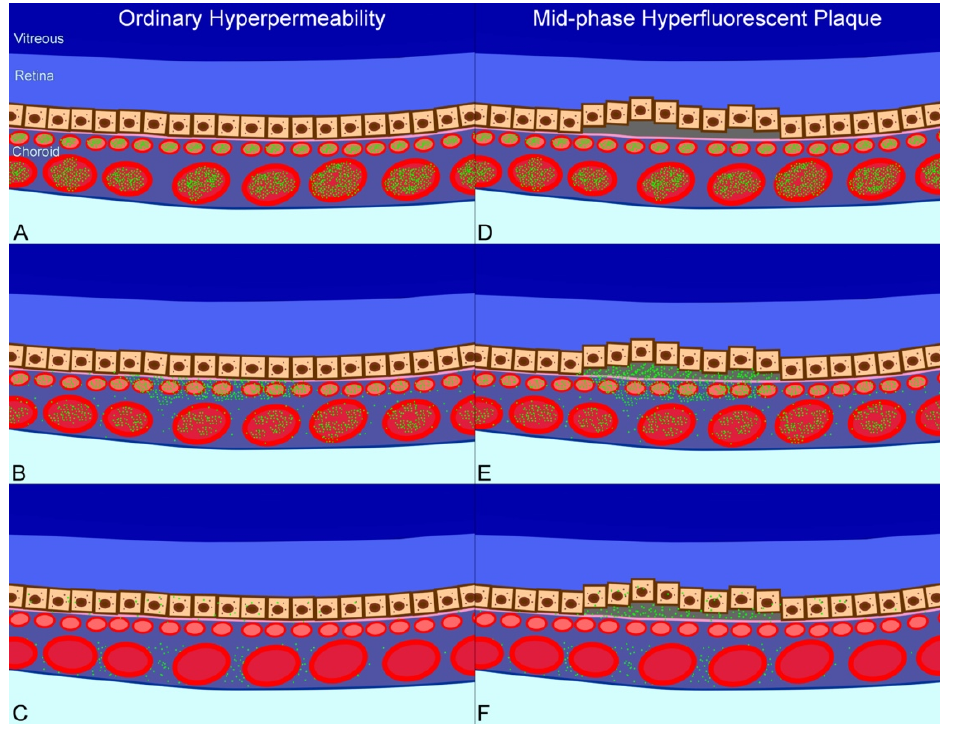
Figure 3. Manifestations of hyperpermeability in central serous chorioretinopathy. ( A ). Soon after injection of indocyanine green, the intravascular dye concentration is high. ( B ). In areas of choroidal vascular hyperpermeability there is leakage of dye into the choroidal stroma. ( C ). The dye is removed from the blood stream by the liver. The dye in the stroma may diffuse back into the blood or spread posteriorly between the larger choroidal vessels. This produces a silhouetting of the large choroidal vessels against a hyperfluorescent background. ( D ). In areas with mid-phase hyperfluo- rescent plaques (MPHP) there appears to be localized, shallow elevations of the RPE monolayer. In some cases, the space has reflectivity greater and more heterogeneous than what would be expected from simple fluid alone. ( E ). Dye leaking in areas of chorodal vascular hyperpermeability may dif- fuse into the choroidal stroma or into the sub-retinal pigment epithelial space. The fluorescence from the anteriorly located dye masks the visible details of the underlying choroid. ( F ). In the later por- tions of the mid-phase, there is retention of dye in the sub-RPE space. The contrast between the regions with retained dye and the lesser amounts remaining in the choroid produces the plaque- like appearance.